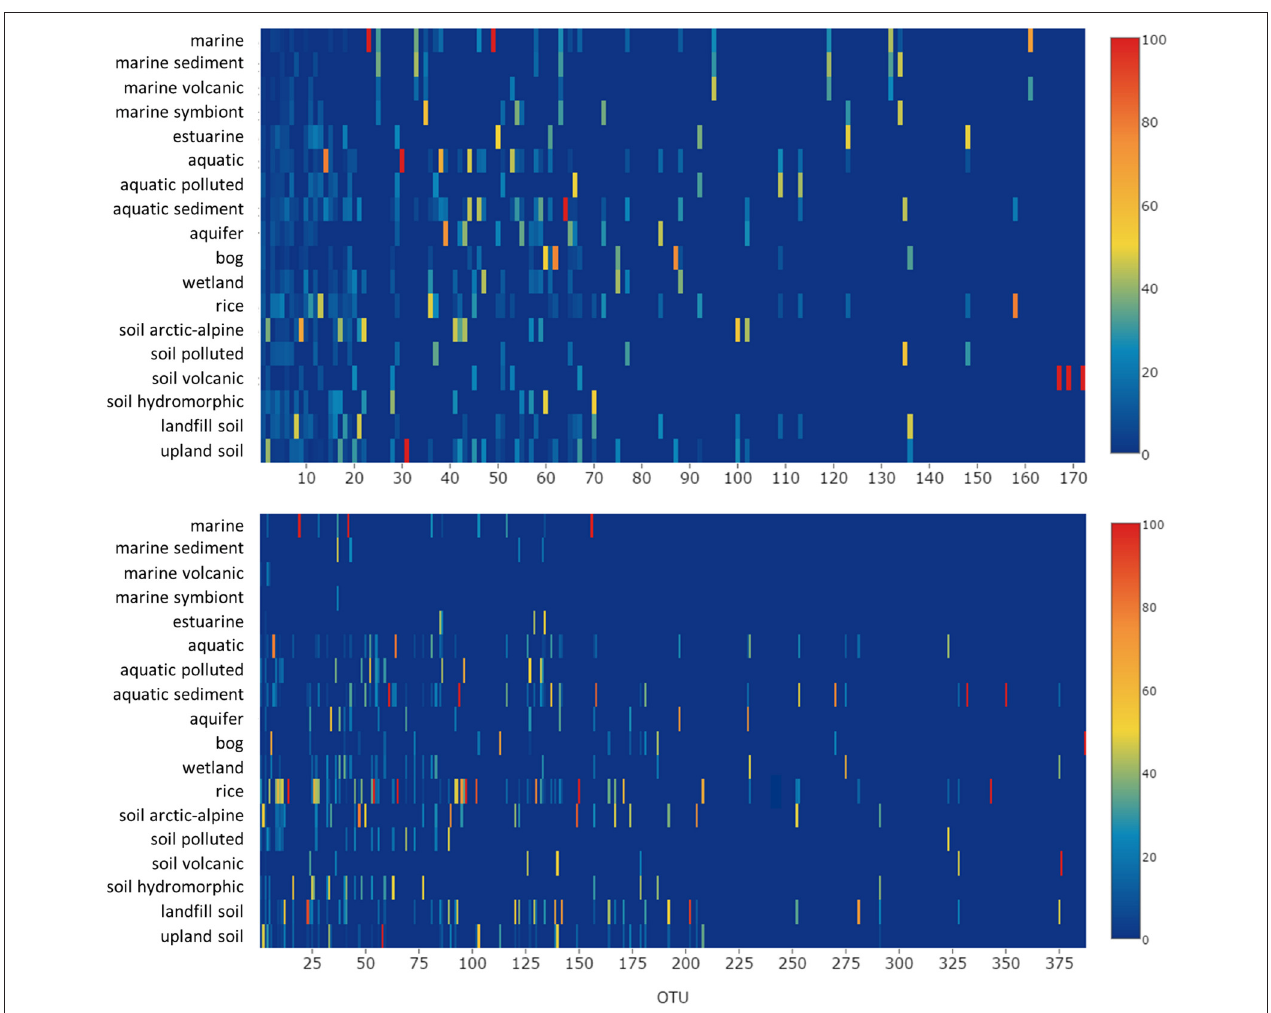
FIGURE 8 | Relative detection frequency of OTUs across habitats. Non-redundant reads were normalized by the number of studies available for each habitat and the relative frequency with which each OTU was detected across the different habitats was calculated. The upper panel shows the results at genus level resolution (OTU 12 ), the lower panel at species level resolution (OTU 4 ). OTUs displayed in red are highly specific for a certain type of habitat. OTUs that were detected in less then five studies were set to zero. The identity of the most habitat-specific and most common OTUs is given in Tables 8 , 9 . A list including detailed information about all OTUs is provided as Supplementary